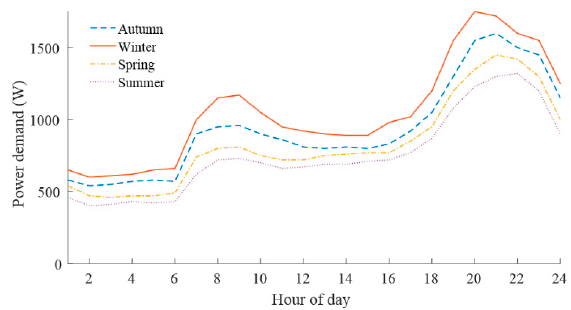
Figure 8. Average daily power consumption per season